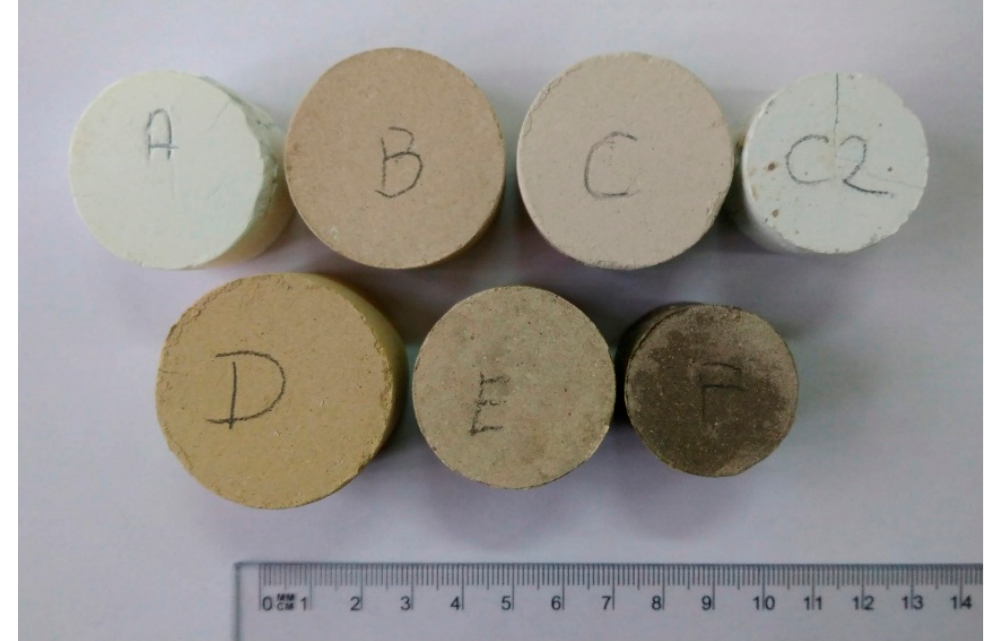
Figure 6. Appearance of the materials obtained after synthesis at 1350 °C for 8 h. The obtained products of the initial synthesis were examined in terms of phase com- position using the XRD method, with a particular focus on the formation of the ye’elimite phase (Table 3). In the case of set A, the desired phase was formed under all firing condi- tions, but its largest amounts (practically, the only product of synthesis) were found in the case of firing at 1350 ◦ C/8 h. The synthesis of set C2 gave similar results. The